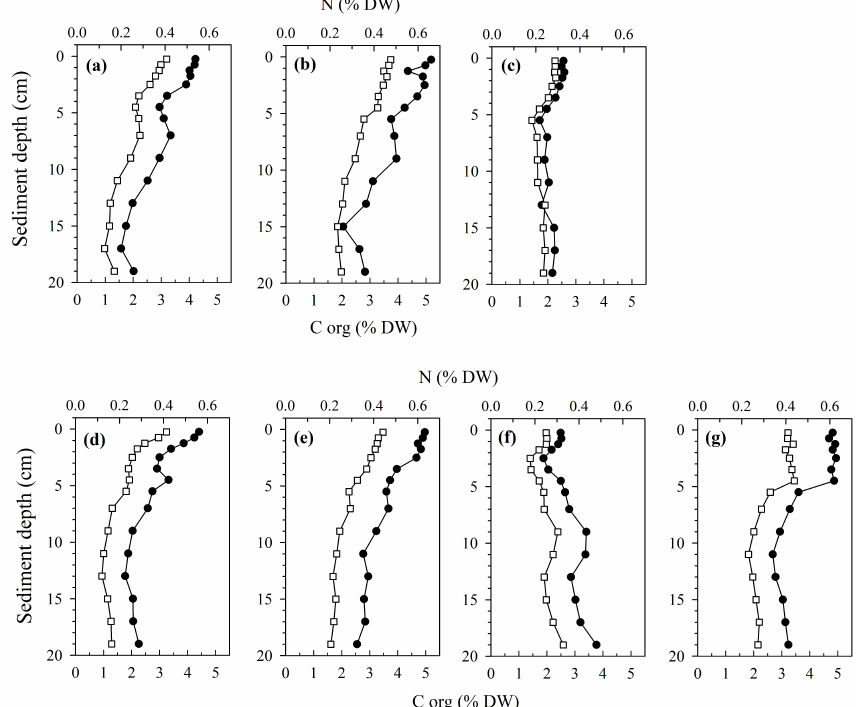
Figure 2. Profiles of organic carbon (C org , represented by black dots) and nitrogen (N, represented by white squares) content in the sedi- mentary solid phase at station GOB1 (a) , GOB2 (b) , and GOB3 (c) in 2013, and GOB1 (d) , GOB2 (e) , GOB3 (f) , and RA2 (g) in 2014. All values are expressed as C org or N percentage of sediment dry weight